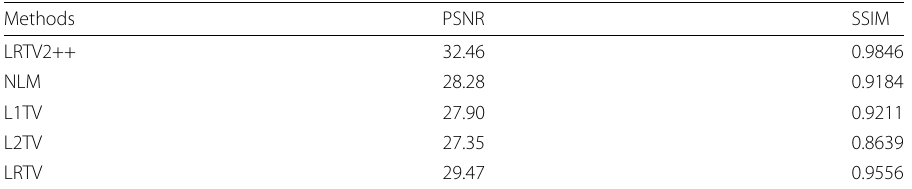
Table 1 PSNR and SSIM index values of each method for image (12-08-2009-RTHEADNECK